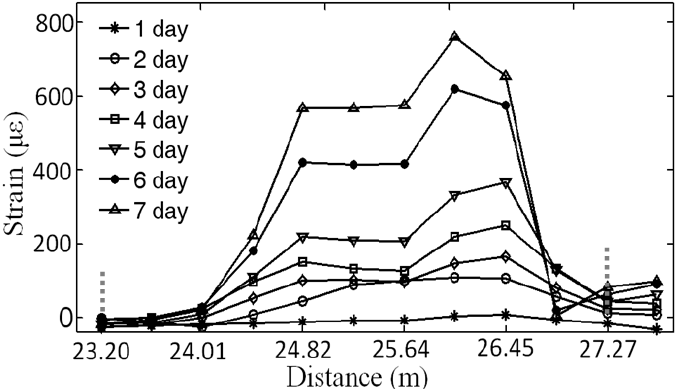
Figure 6. Distributed strain caused by the corrosion expansion was monitored by BOTDA within 7 days corresponding to the 3-meter length of the sensing fiber.